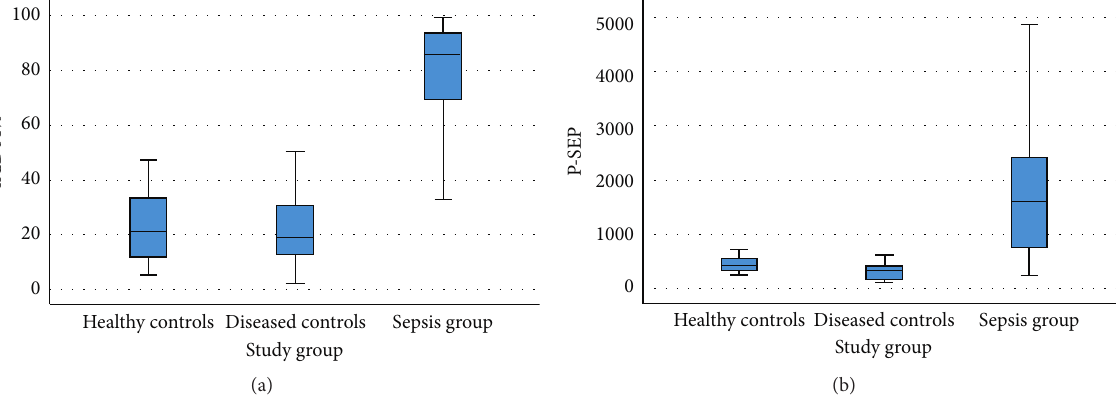
Figure 2: nCD64 and presepsin box plots for the healthy controls, diseased controls, and sepsis patients’ groups. (a) nCD64% significantly increased ( P < 0 . 001) in sepsis {median [IQR]: 85.6 (65.5–93.85)%} when compared to the healthy controls {median [IQR]: 21.3 (11.65–33.85)%} and the diseased controls {median [IQR]: 19 (12.85–31.25)%}, but no significant difference was found when healthy and diseased controls were compared together ( P � 0 . 934). (b) Presepsin significantly increased ( P < 0 . 001) in sepsis {median [IQR]: 1645 (748–2425)pg./ml} when compared to the healthy controls {median [IQR]: 434 (339.5–595) pg./ml} and the diseased controls {median [IQR]: 339 (152.5–413)pg./ml}. Additionally, a statistically significant difference existed when healthy controls and pathological controls were compared together ( P � 0 . 001), being lower in the diseased controls than the healthy